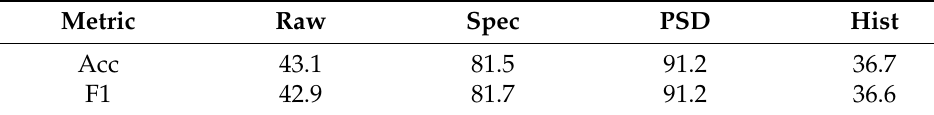
Table 4. Evaluation Data Accuracy (%) F1-Score